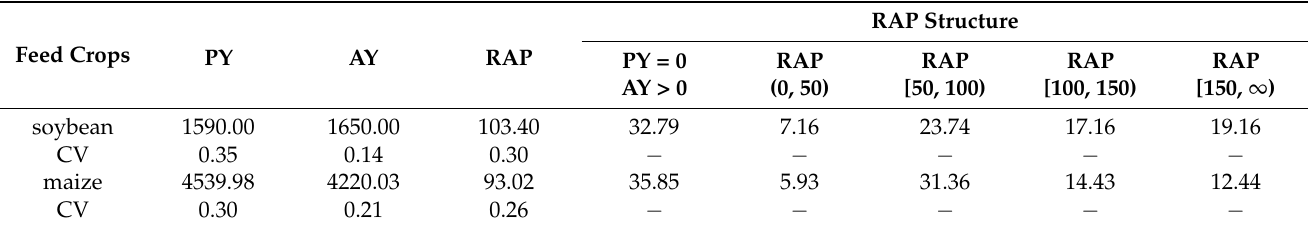
Table 2. The AY/PY and RAP structure of soybean and maize in China (kg · hm − 2 ,